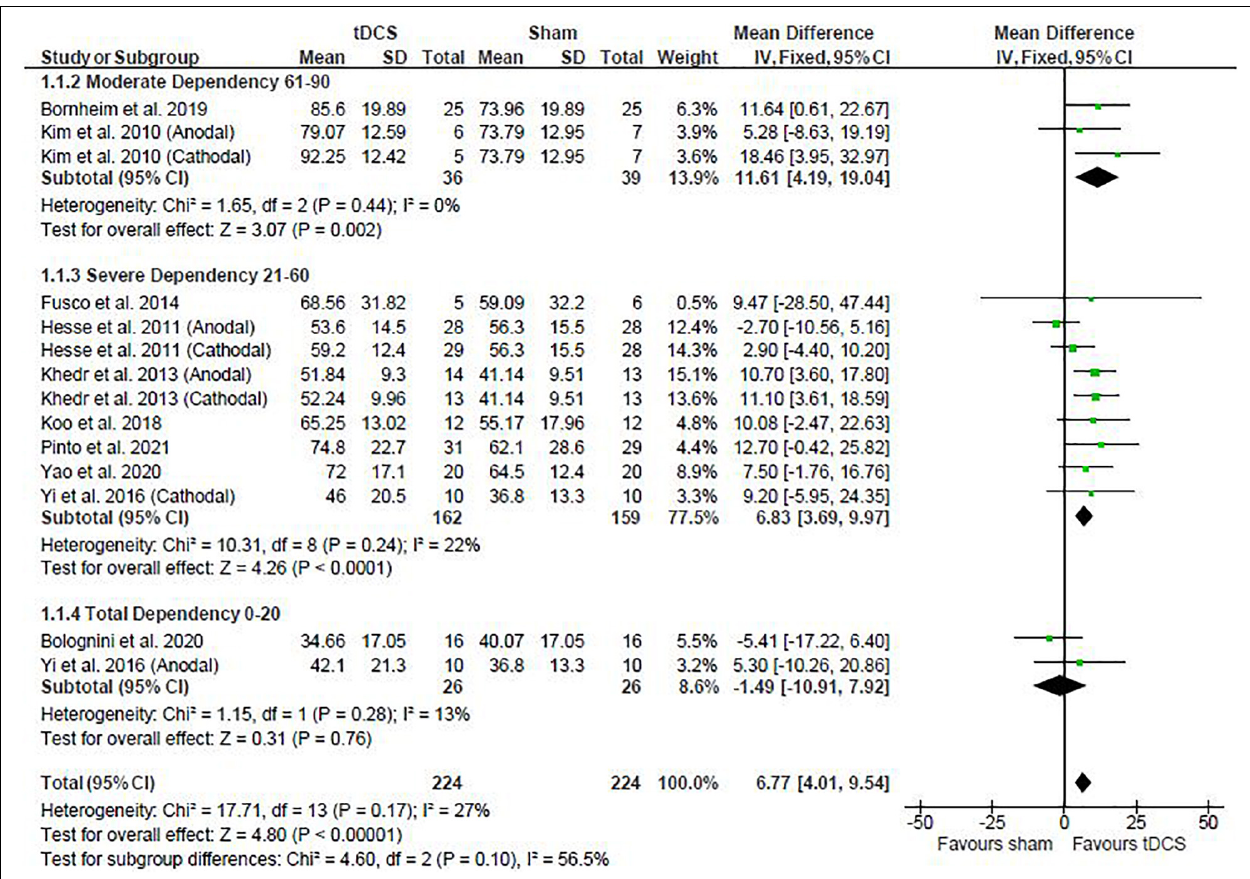
FIGURE 1 | Effects of transcranial direct current stimulation (tDCS) on stroke recovery as assessed by the post-intervention data of the tDCS and sham groups for the Barthel Index.